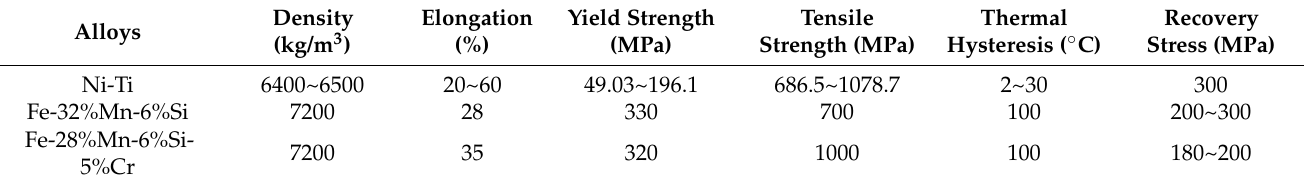
Table 1. Characteristics comparison of Ni-Ti alloys and Fe-Mn-Si alloys